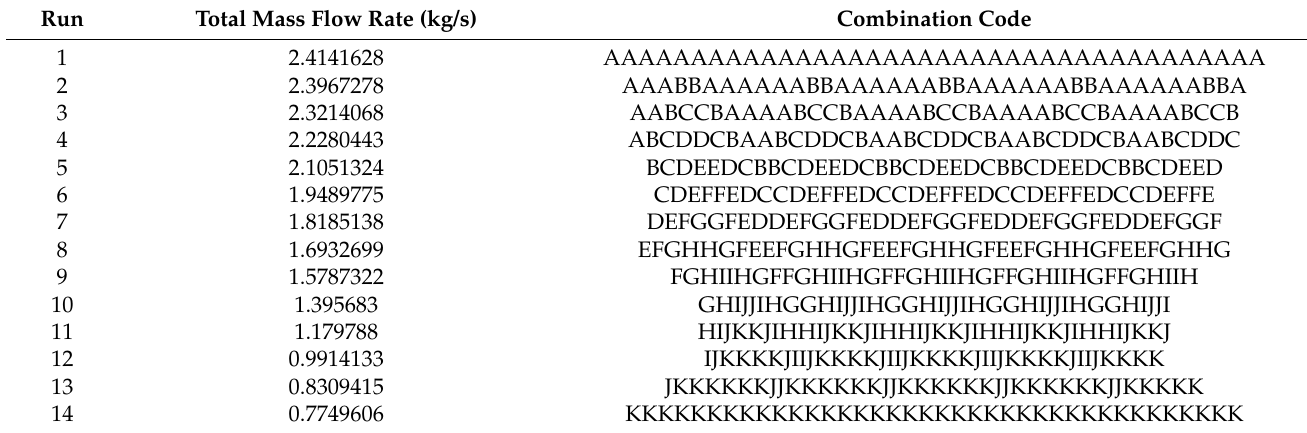
Table 6. Combinations of mass flow rates for five stall cells.